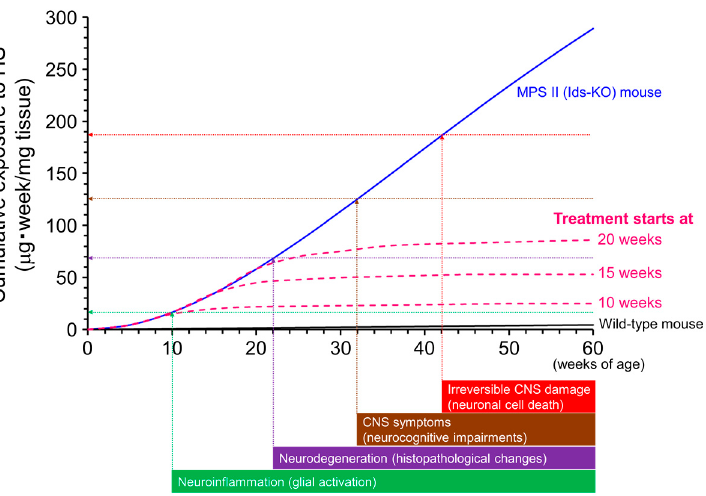
Figure 7. Conceptual diagram of the association between the cumulative exposure of the brain to heparan sulfate (HS) and neurological impairments. The cumulative exposure levels estimated from the actual brain HS concentrations in mucopolysaccharidosis (MPS) II mice increase with age (blue curve). Vertical arrows are the presumed times of onset of neurological events. Horizontal arrows are the postulated levels of cumulative exposure of the brain to HS when corresponding neuronal events occur. Values of the y-intercepts are tentative. The pink dashed curves indicate the presumed cumulative exposures to HS if HS-decreasing treatment for the brain was started at different weeks of age. Note that this graph is simplified to help understand the role of cumulative exposure of the brain to HS over time. Other factors associated with age may be involved in the development of central nervous system (CNS) disorders, but these are not under consideration here. Reproduced from